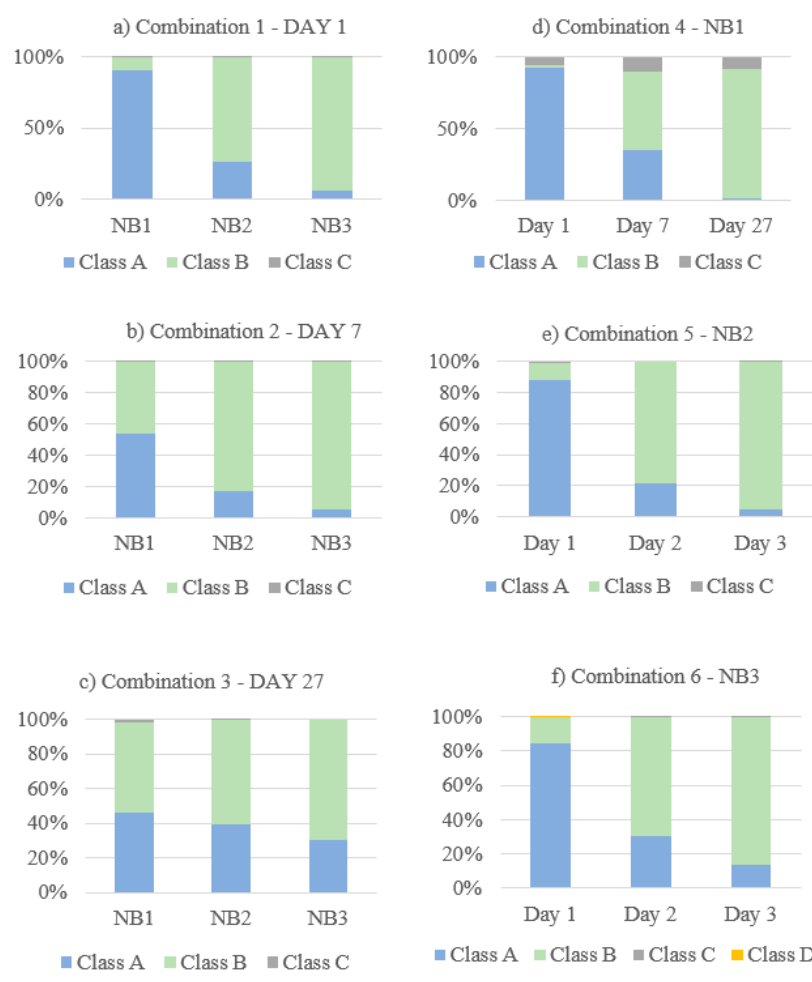
Figure 11. Class distribution graphs for the analyses of combinations 1–6 ( a – f ).